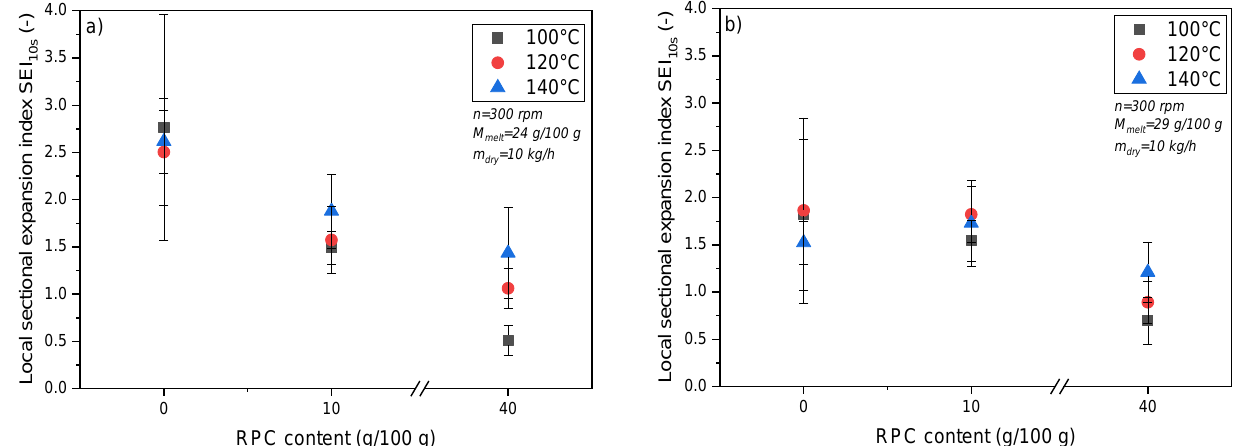
Figure 3. Intermediate sectional expansion index (SEI 10s ) of maize starch (MS) extruded as a pure component or in blends with 10 or 40 g/100 g (w.b.) rapeseed press cake (RPC). Samples were processed at a barrel temperature (T Barrel ) of 100, 120 or 140 °C, a mass flow rate (m dry ) of 10 kg/h, a moisture content (M melt ) of ( a ) 24 g/100 g (d.m.) or ( b ) 29 g/100 g (d.m.) and a screw speed (n) of 300 rpm.